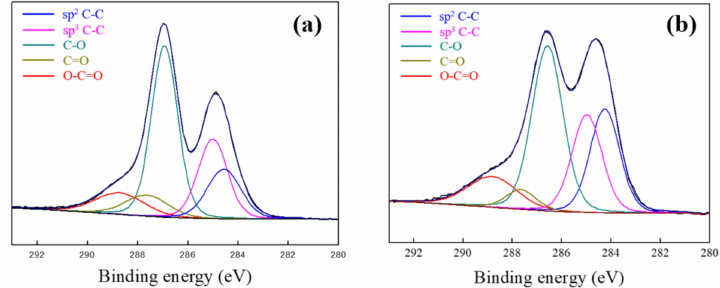
Figure 4. C1s peaks of XPS spectrum: ( a ) graphene oxide and ( b ) Al / GO 0.3wt.%. Table 1. Curve fitting results of XPS C1s spectra of the GO and the Al / GO 0.3 wt.%.